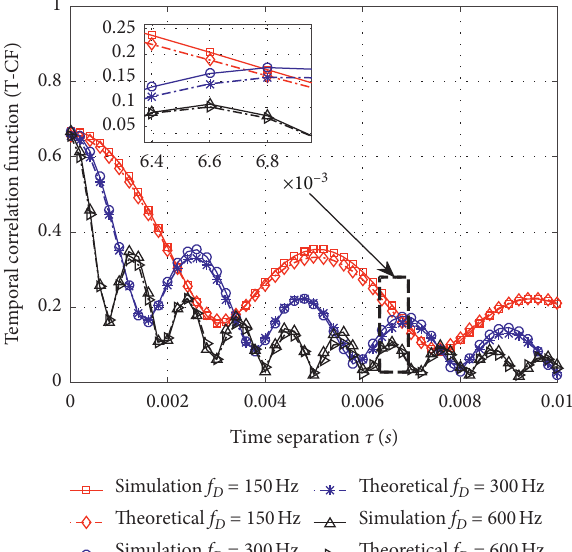
Figure 6: T-CF of LCX-MIMO for different time separation τ with different Doppler shifts f (360 km/h)] of the receiver and d � 4.8 λ , K 11 � K 12 � 4dB, l � 0.5m.